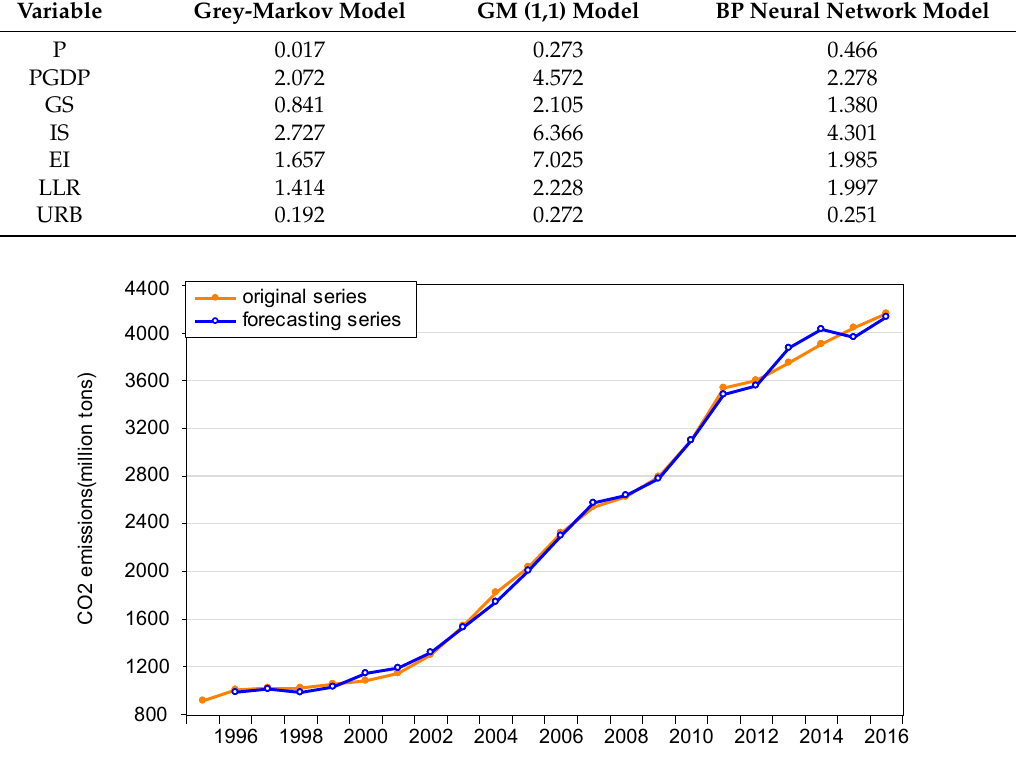
Figure 9. The forecasting result for CO 2 emissions in the electricity generation sector by the PLS-Grey-Markov model from 1995 to 2016.